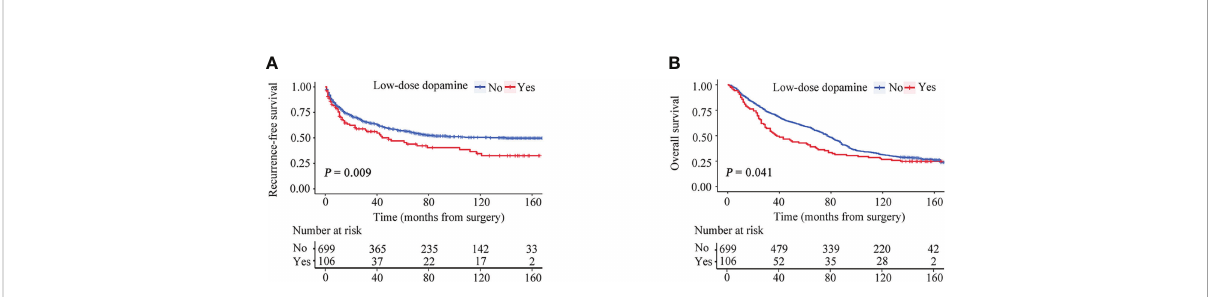
FIGURE 2 Recurrence-free survival (RFS) and overall survival (OS) curves strati fi ed by dose of dopamine before propensity score matching. (A) RFS curves. (B) OS